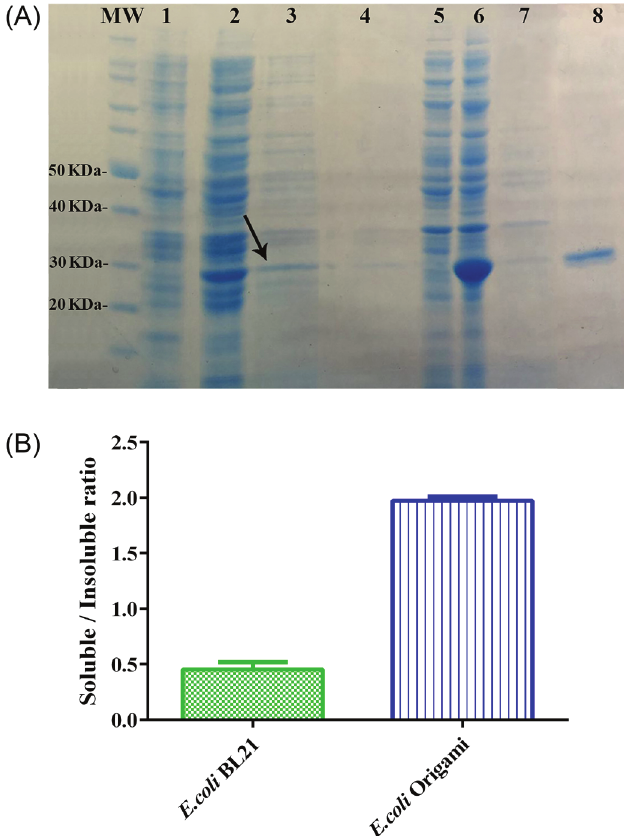
FIGURE 4 - Analysis of solubility of recombinant anti-HER2 scFv expressed in E. coli Origami (DE3) and BL21 (DE3). A) Proteins expression was induced for 24 h at 37 ° C using 1 mM IPTG. (MW) protein marker (Fermentas), the total protein of E. coli Origami (DE3) containing pET-22b (anti-HER2 scFv) plasmid before induction (lane 1), after induction (lane 2), soluble (lane 3) and insoluble (lane 4) fractions of recombinant Origami (DE3) lysate, total protein of E. coli BL21 (DE3) containing pET-22b (anti-HER2 scFv) plasmid before induction (lane 5), after induction (lane 6), soluble fraction (lane 7) and insoluble fractions (lane 8) of recombinant BL21 (DE3) lysate. B) The soluble to insoluble ratio of anti-HER2 scFv expression in E. coli Origami (DE3) and BL21 (DE3) strain which were evaluated by using the Total Lab TL 120 software.